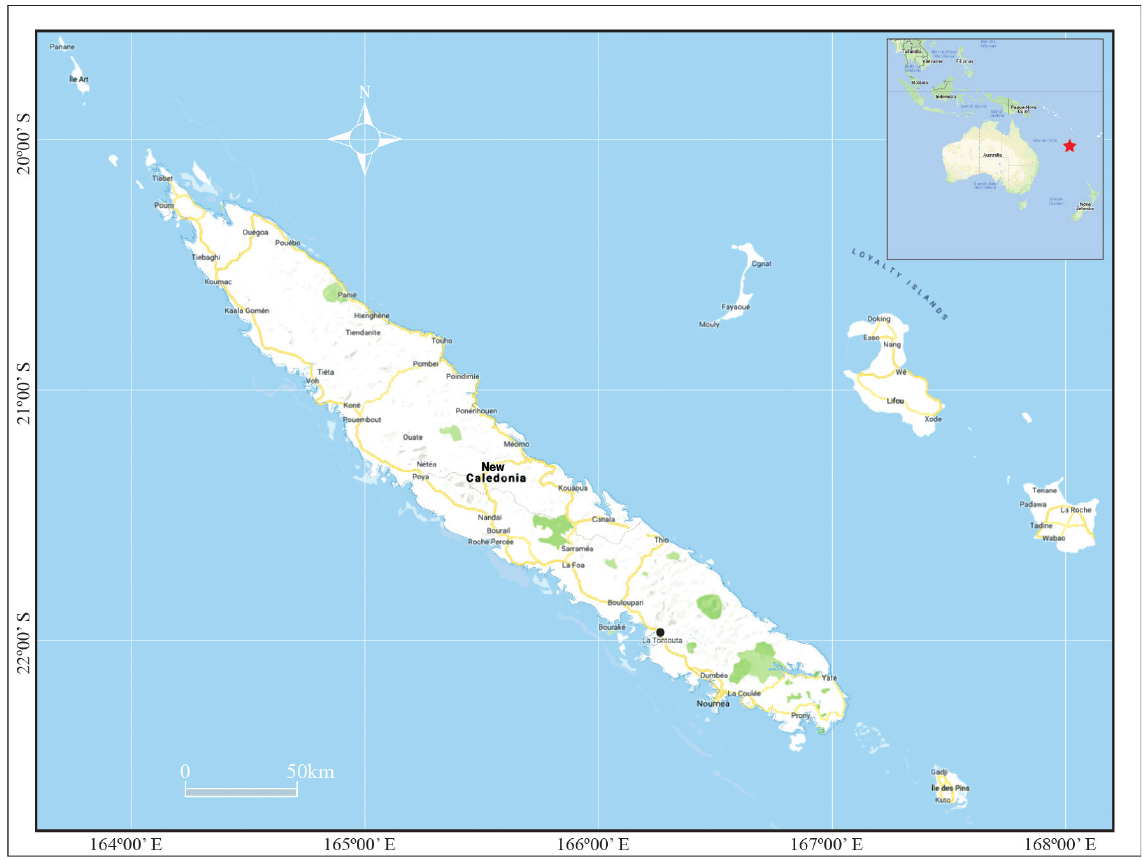
Fig. 1. Map of New Caledonia, showing type locality on Grande Terre, near La Tontouta.